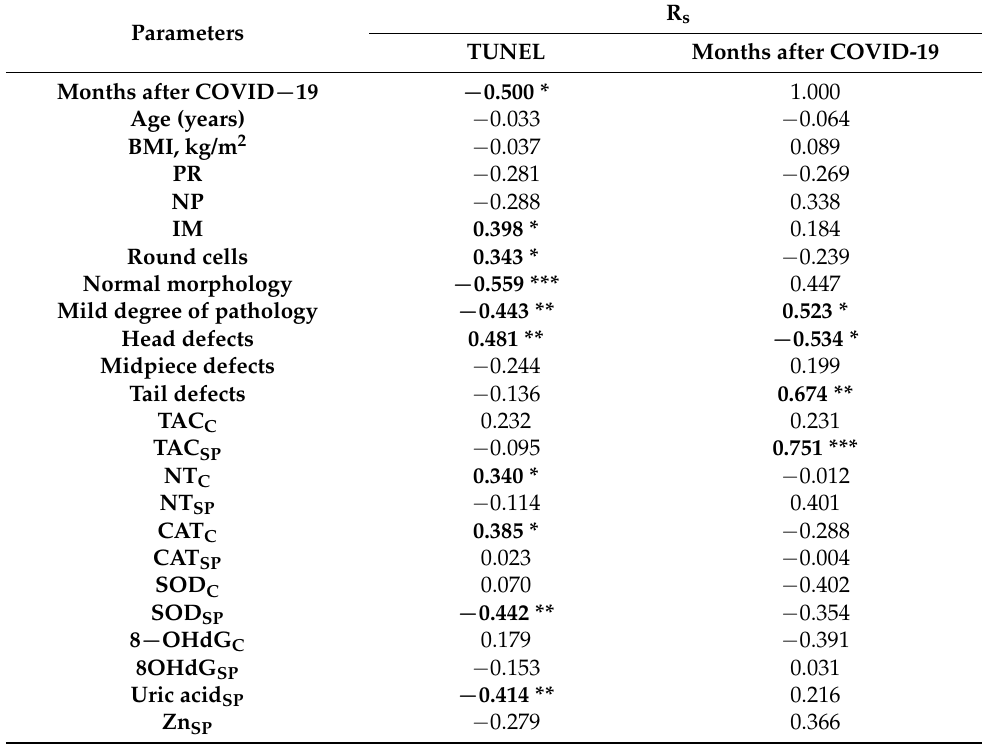
Table 1. Matrix of correlation coefficients of the investigated parameters with TUNEL and COVID factors. Parameters